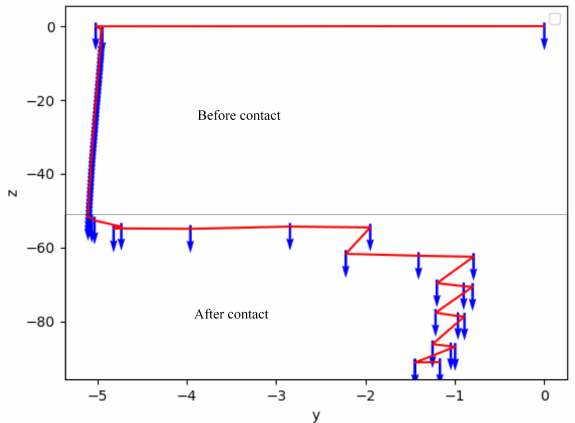
Figure 13. The trajectory of the end of the peg during insertion.